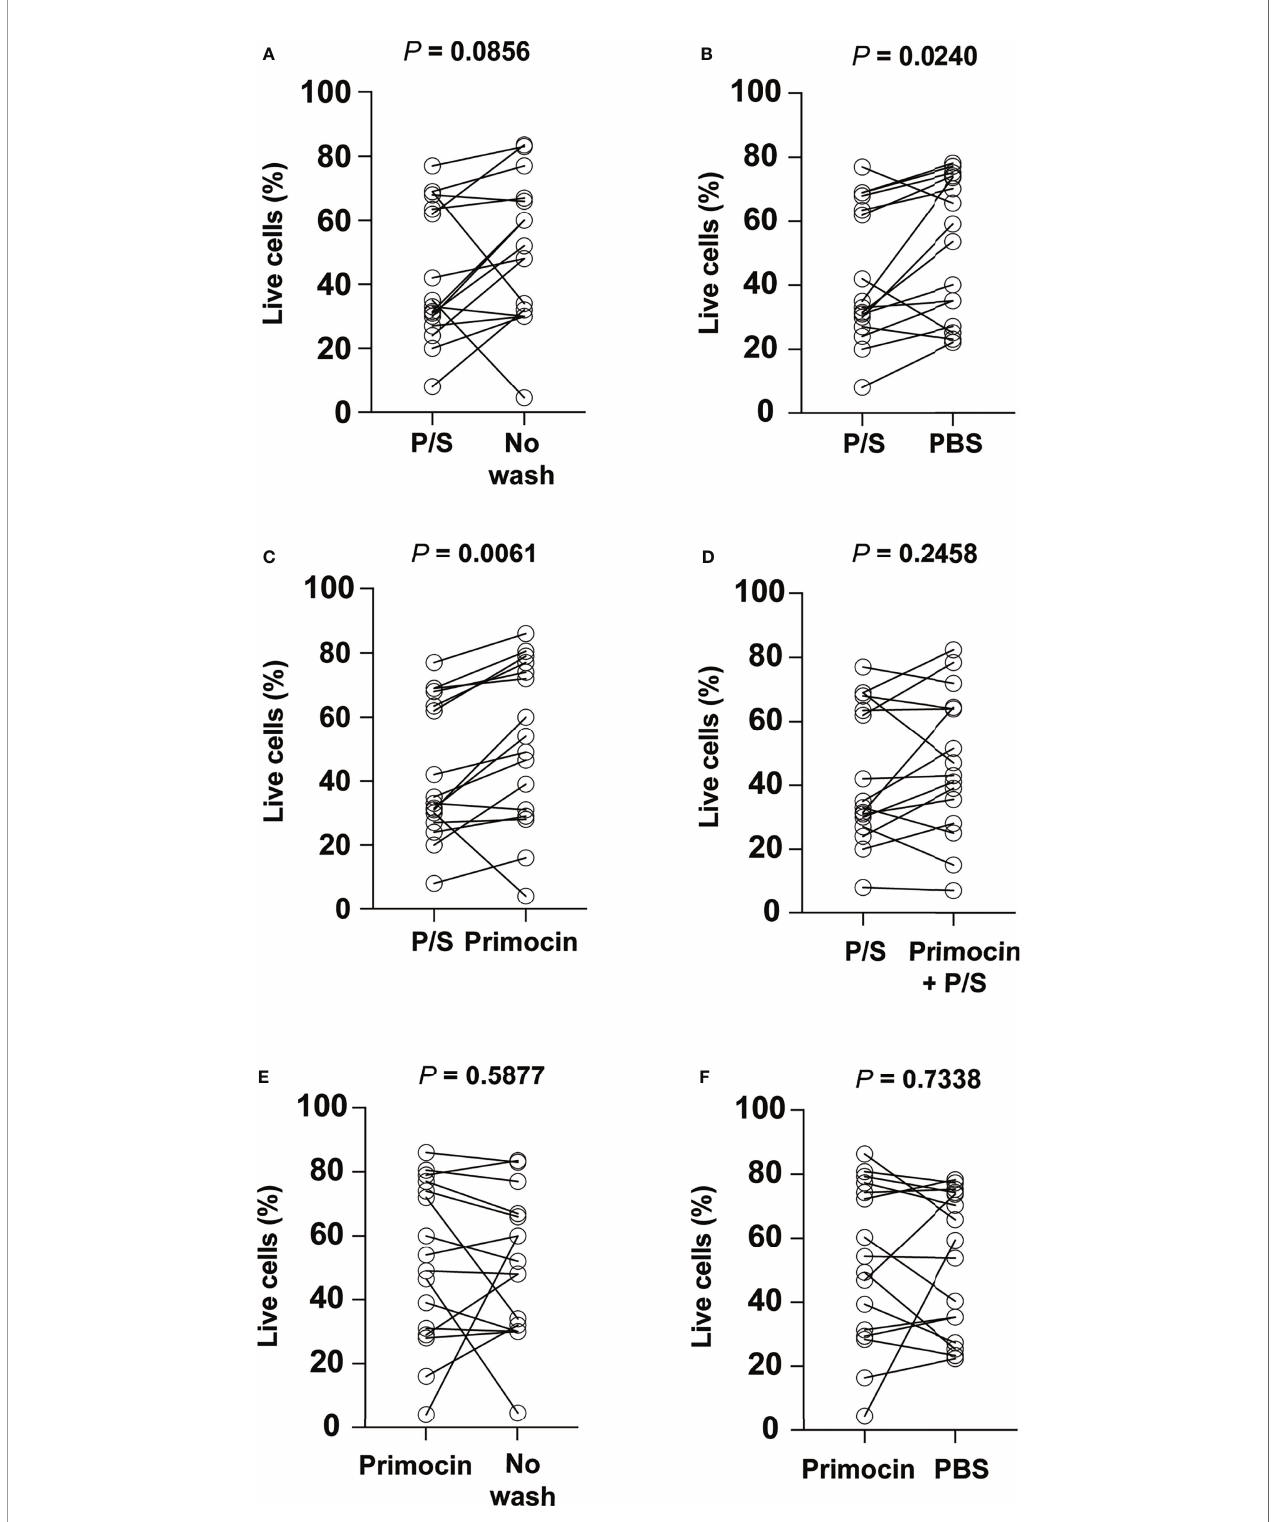
FIGURE 4 | The use of penicillin/streptomycin during the washing process negatively impacts cell viability. Comparison of the percentage of viable cells obtained using penicillin/streptomycin as a washing solution with (A) No wash, (B) PBS, (C) Primocin, and (D) penicillin/streptomycin and Primocin. Further cell viability comparison between Primocin and no wash and Primocin and PBS washing conditions is shown in (E) and (F) ,